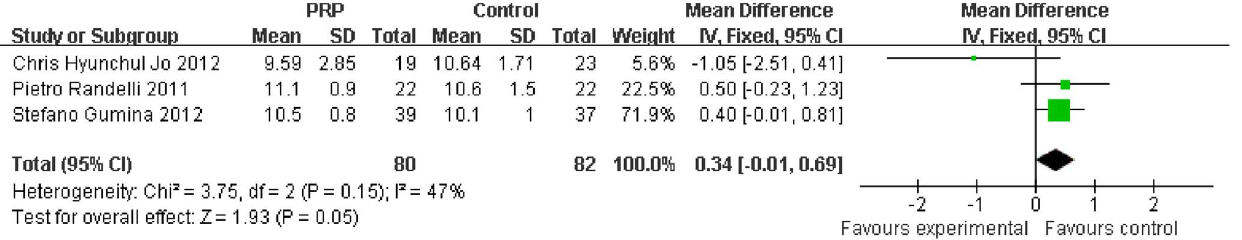
Figure 6. Difference in the SST scale.